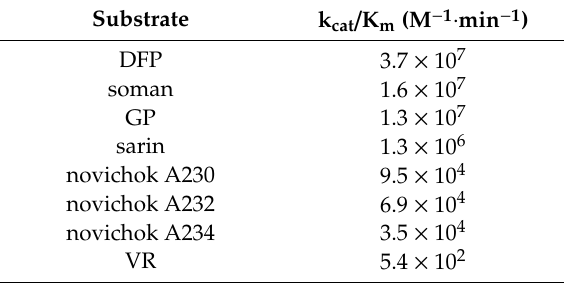
Table 3. Organophosphorus substrate specificity for Alteromonas sp. JD6.5 OPAA [87,88,92,93].